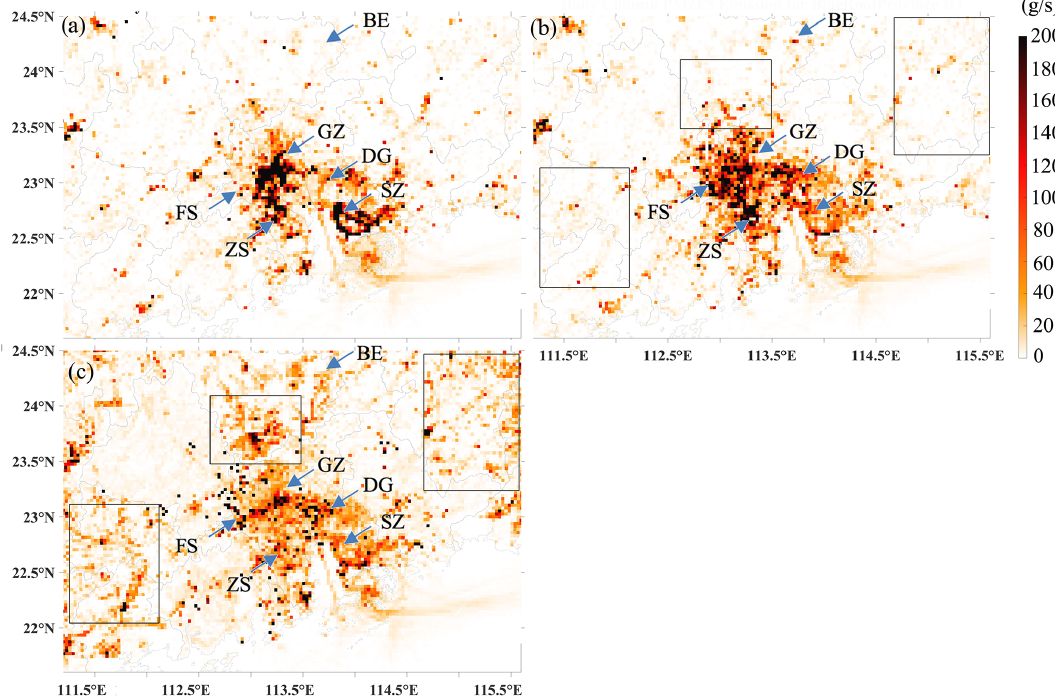
Figure 5. Daily column total of PM 2 . 5 emission from D3 (3km) domain: (a) base case, (b) blue-roof case, and (c) point- and area-based btmUp case. Note: blue arrows indicate Foshan (FS), Guangzhou (GZ), Shenzhen (SZ), Dongguan (DG), Zhongshan (ZS), and BE (blue-roof example). Boxes indicate the locations with large spatial differences between the blue-roof and the btmUp cases.